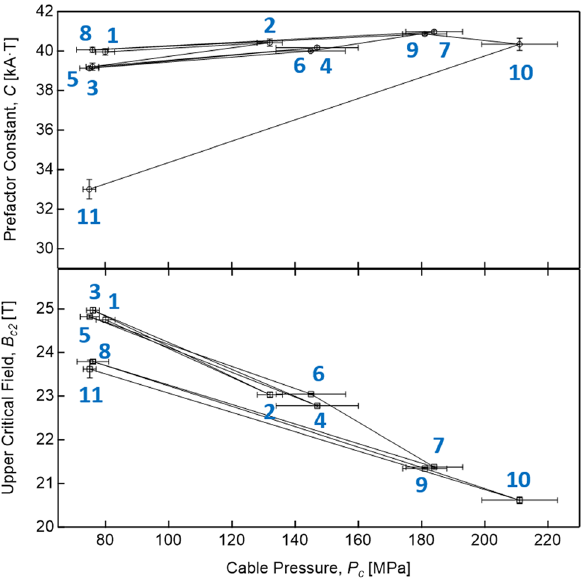
Figure 3. The upper critical field, B c2 , and the prefactor constant, C , obtained from fits of (4) to the experimental I c ( B ) curves, calculated at different transversal